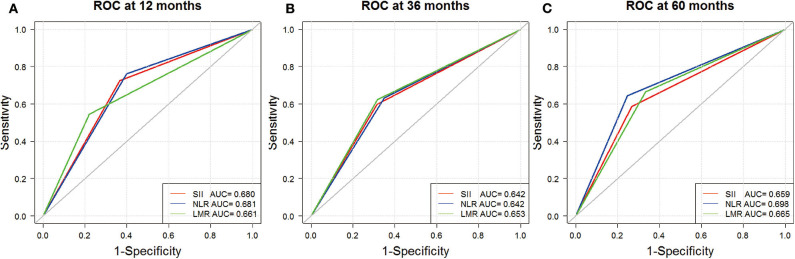
Receiver operating characteristic analyses for SII (red), NLR (blue), and LMR (green) at 12 (A), 36 (B), and 60 months (C).